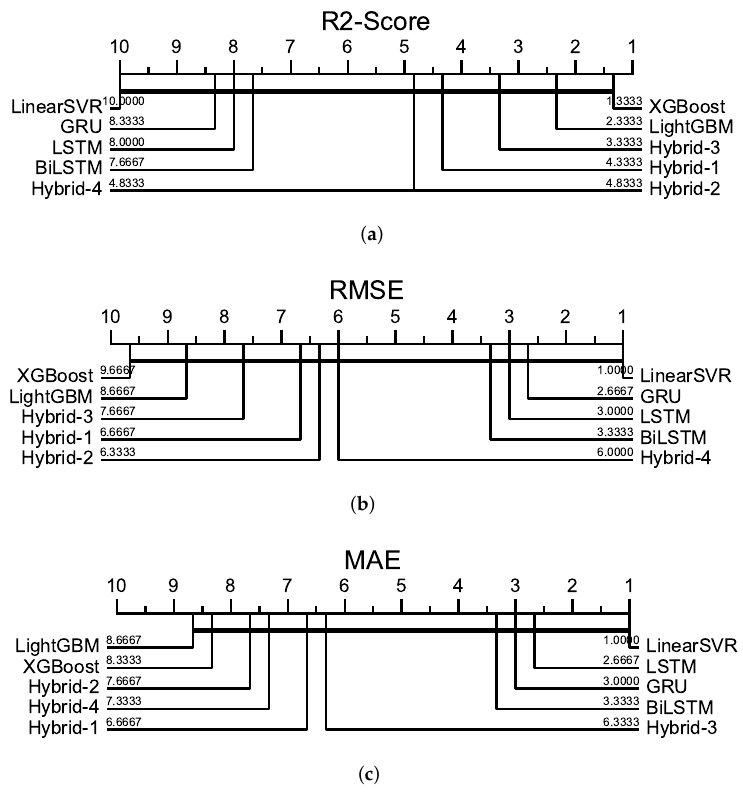
Figure 3. CD Diagrams Comparing the Performance of TTP Methods across the Three Data Sets. ( a ) R 2 . ( b ) RMSE. ( c )